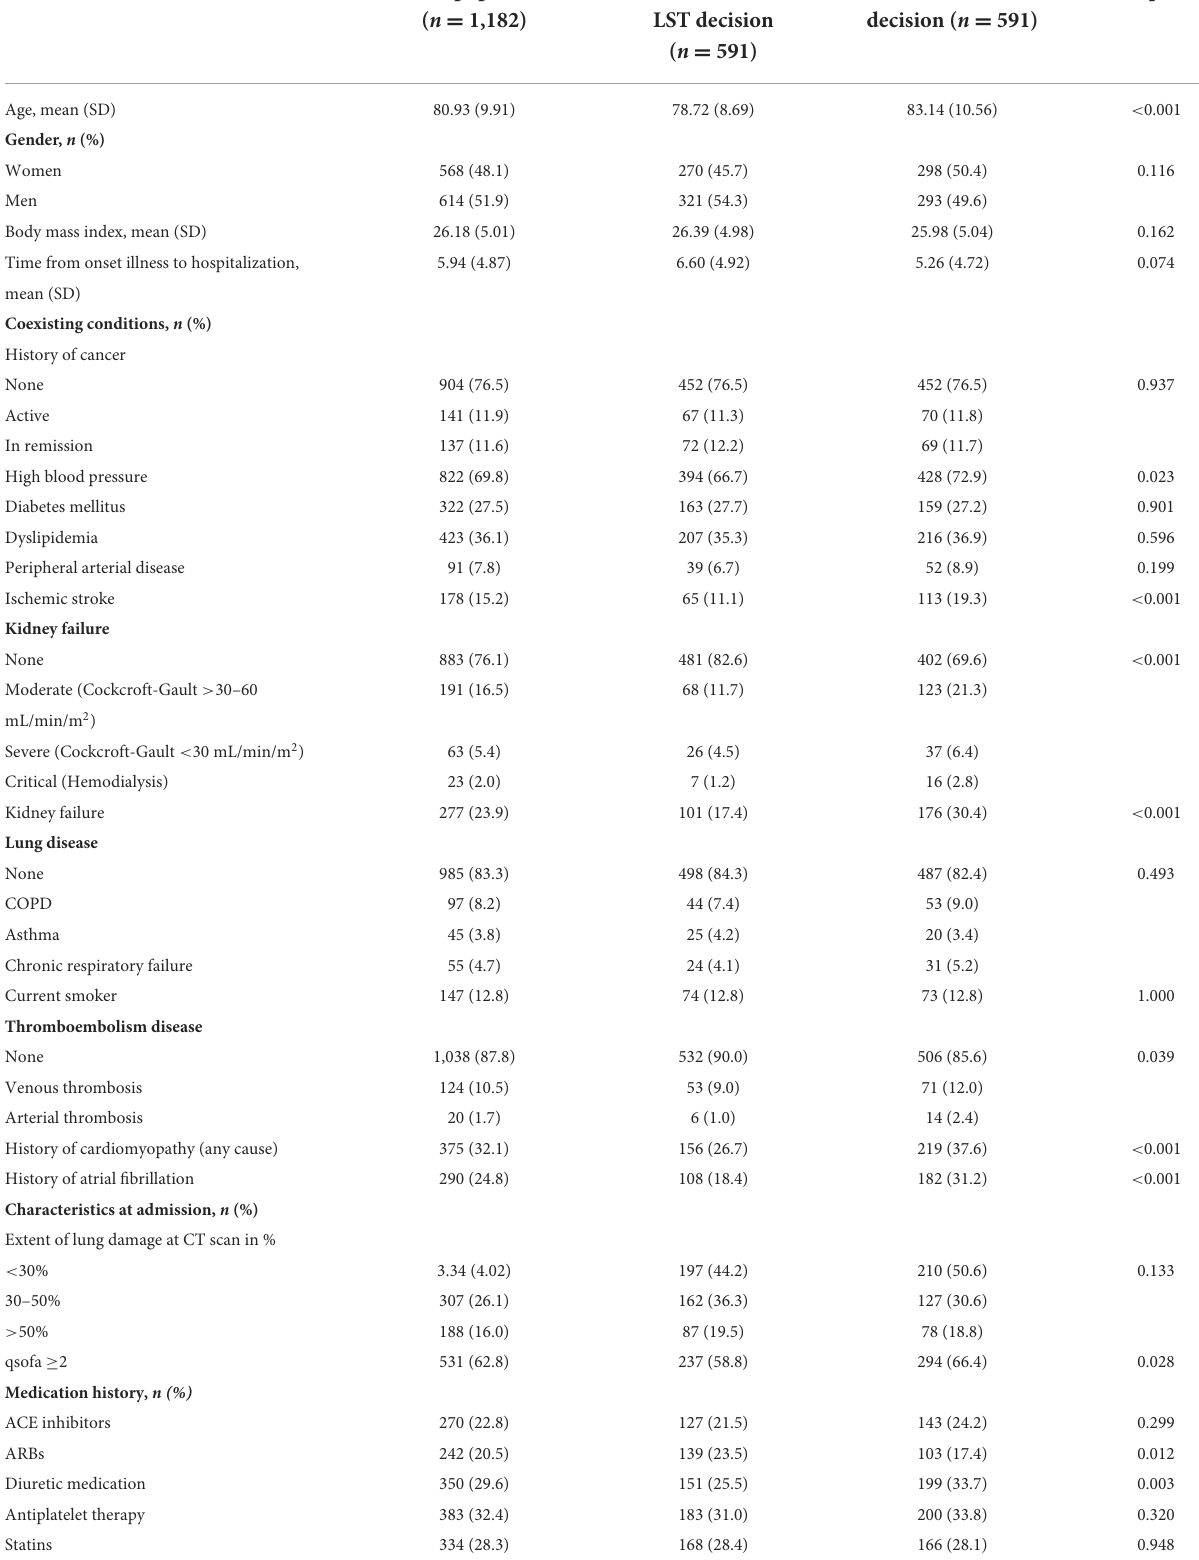
TABLE 1 Baseline characteristics of the population in a retrospective study for a matched population in LST patients with COVID-19 admitted in medical wards.